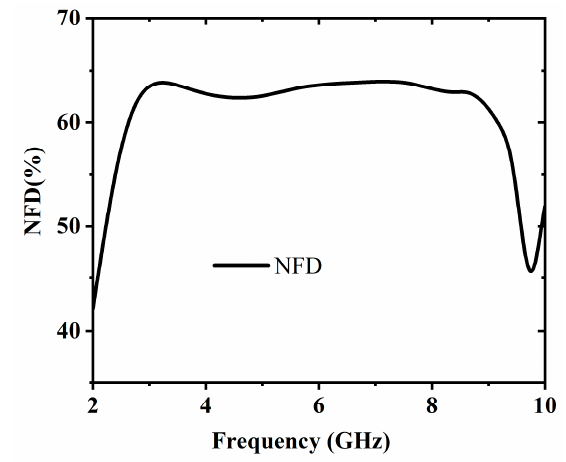
Figure 11. Near field directivity of the proposed prototype with imaging setup.